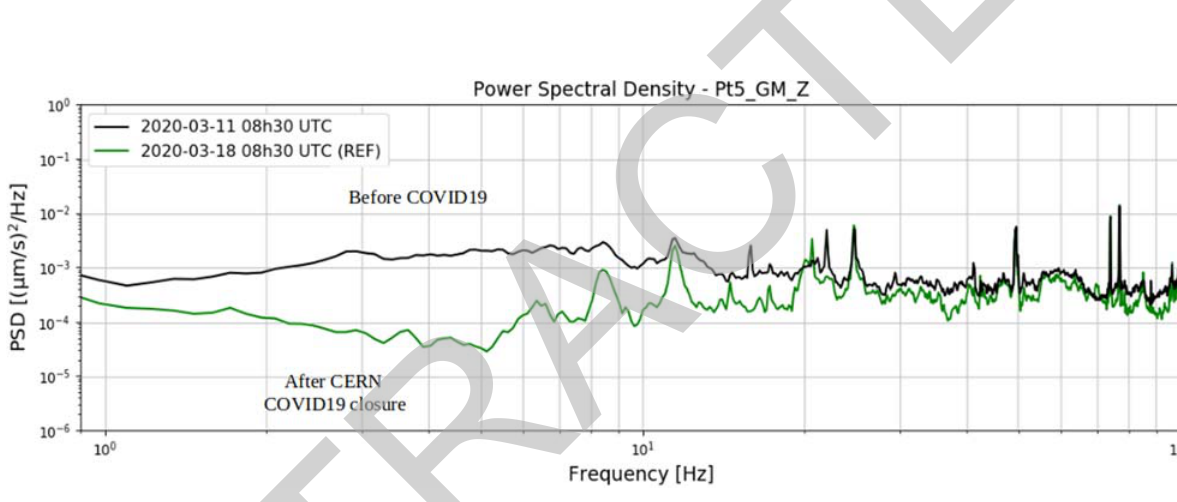
Figure 5: PSD graph for the 20 - min data block from seismic station at the surface ( CERNS ) before ( black line ) and after ( green line ) COVID - 19 CERN closure.